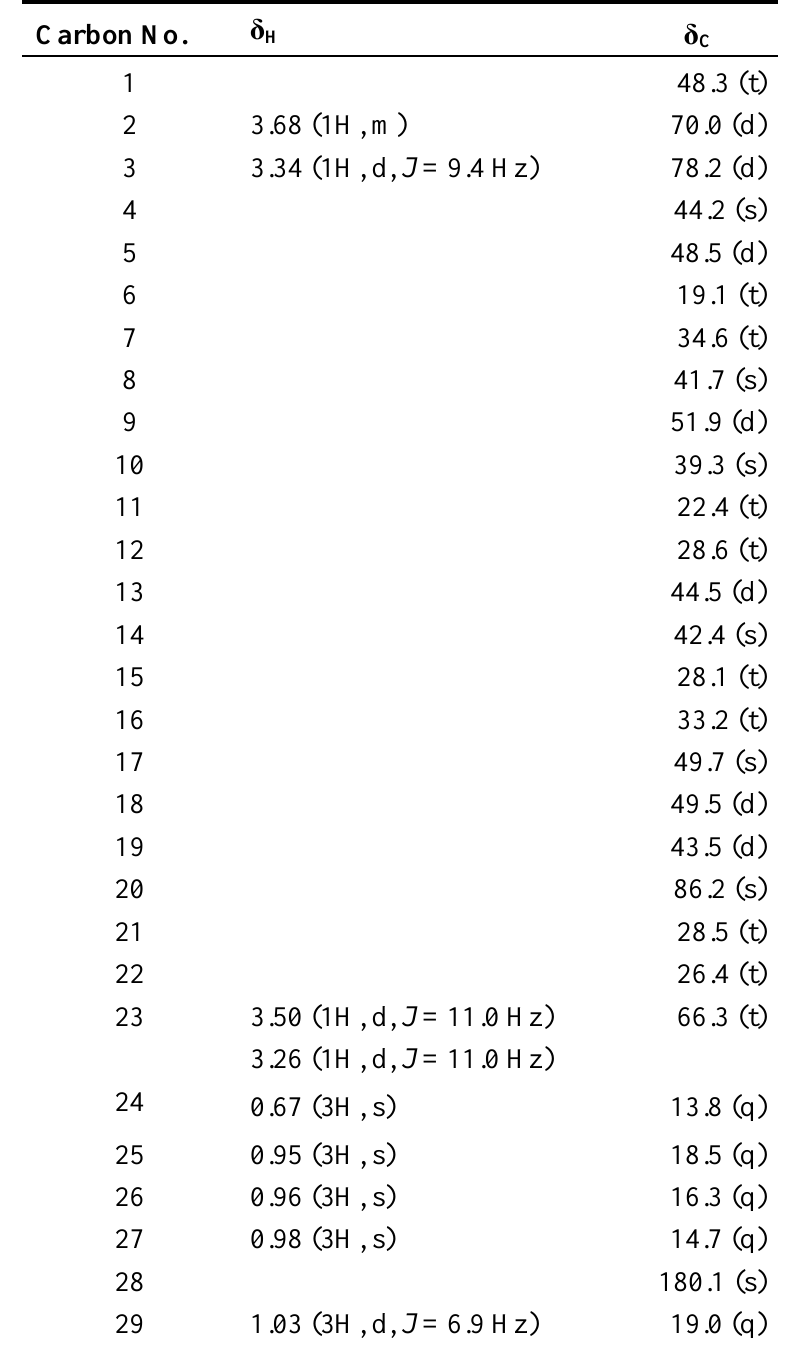
1 H-NMR (300 MHz), and 13 C-NMR (75 MHz) data of 1 (CD OD, TMS, δ 3